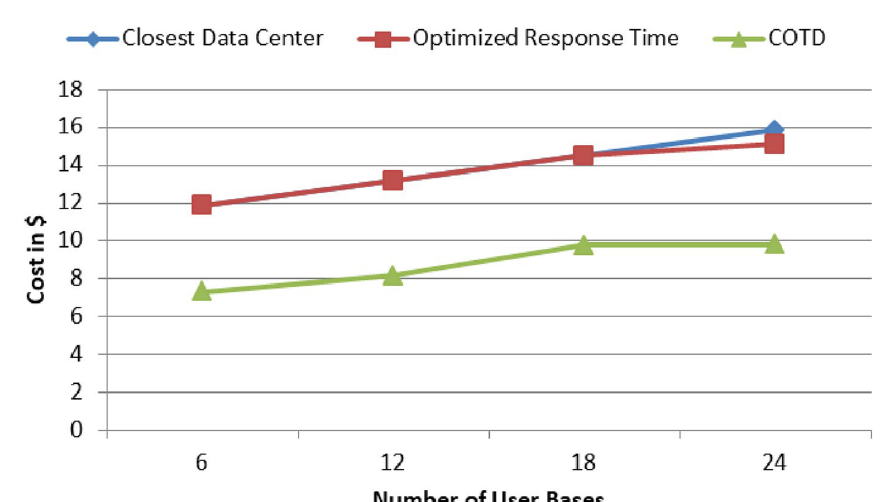
Fig. 11 Impact of COTD on cost in varying